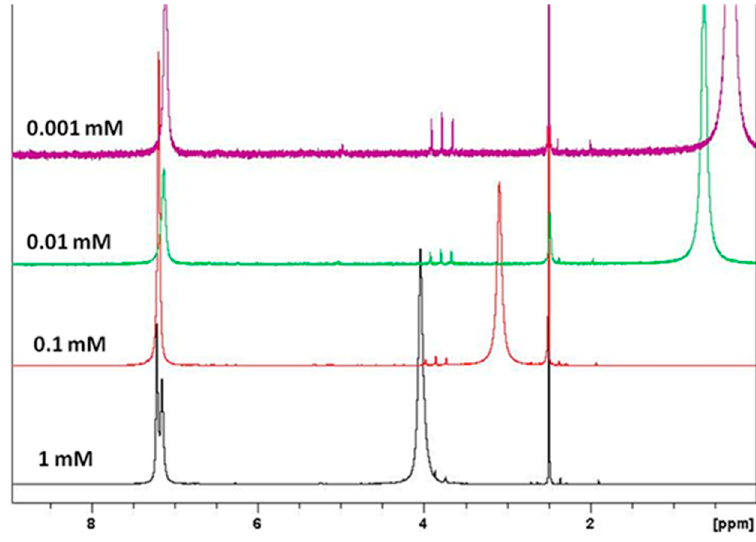
Figure 4. 1 H-NMR spectra of compound G1 in DMSO- d 6 at 0.001, 0.01, 0.1 and 1 mM at 20 °C.